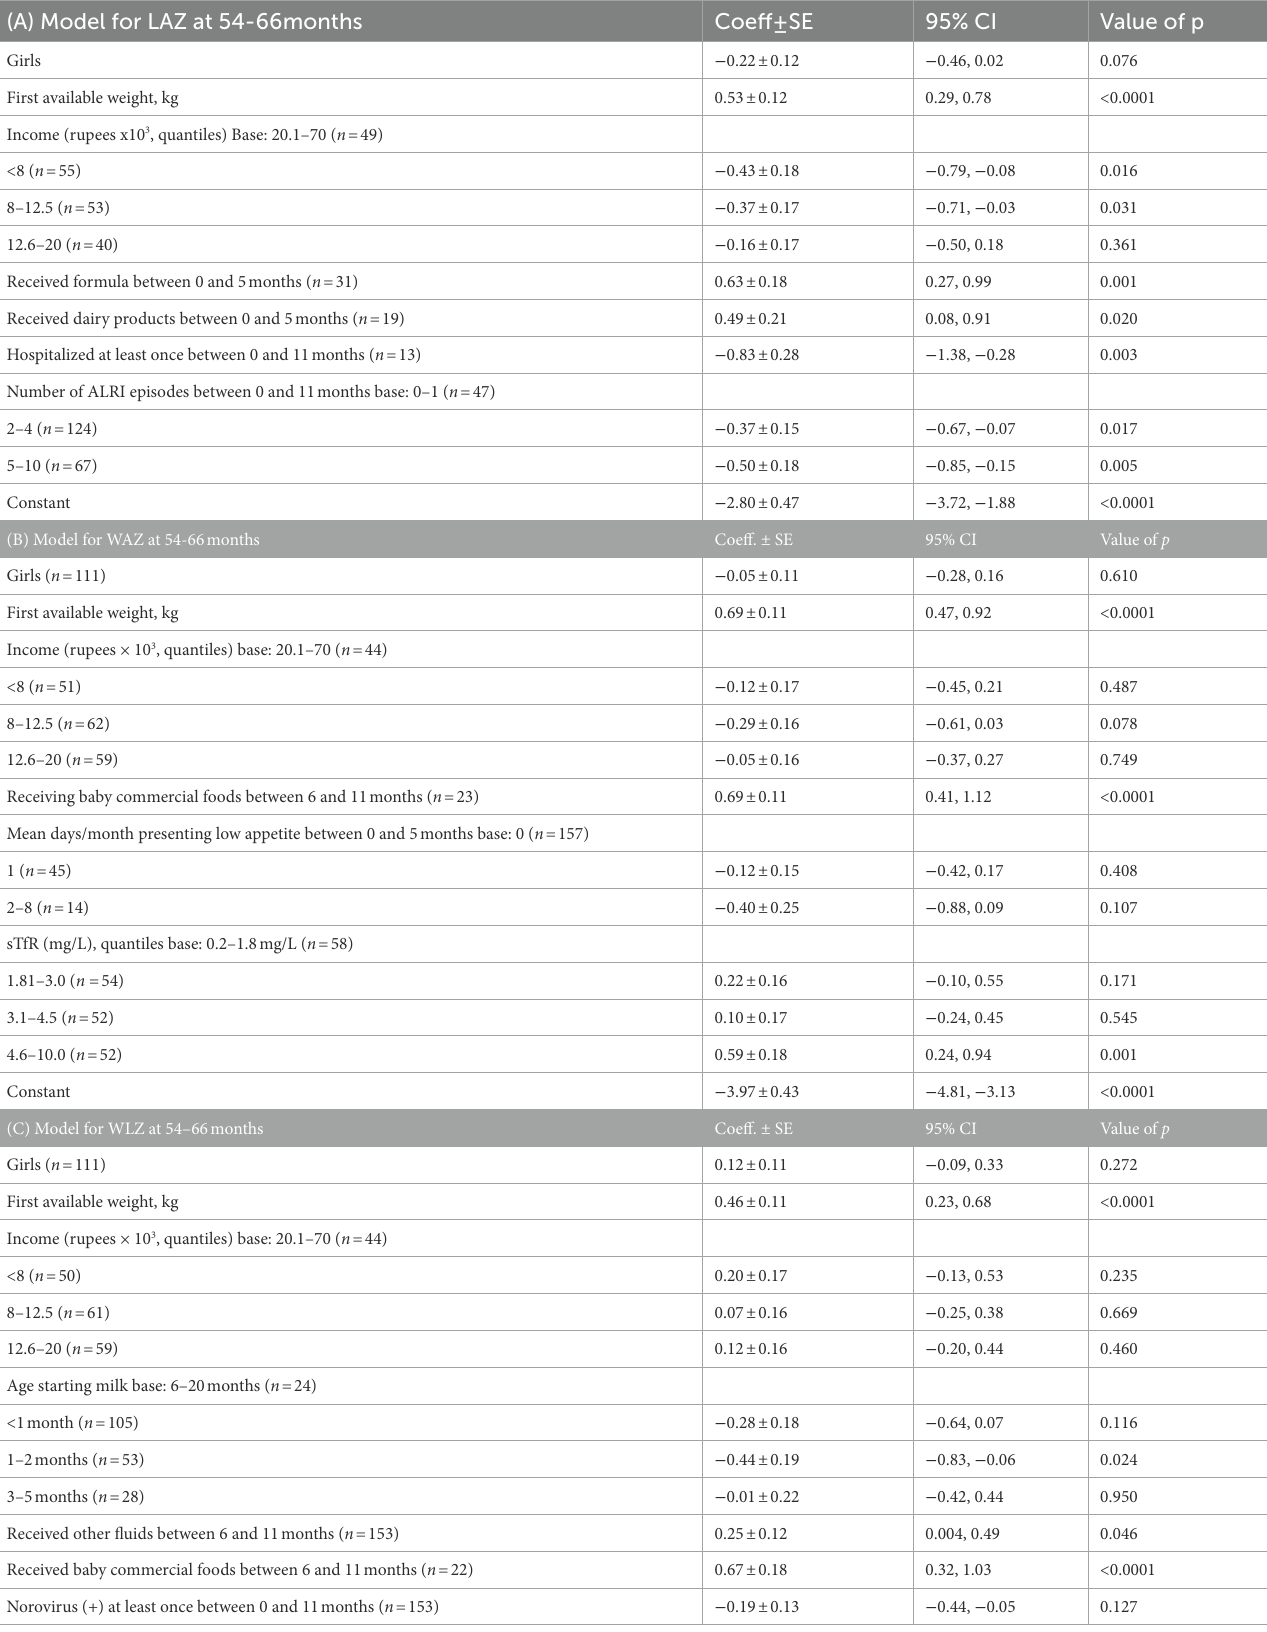
TABLE 4 Multivariate linear regression models for (A) LAZ, (B) WAZ, and (C) WLZ. (A) Model for LAZ at 54-66